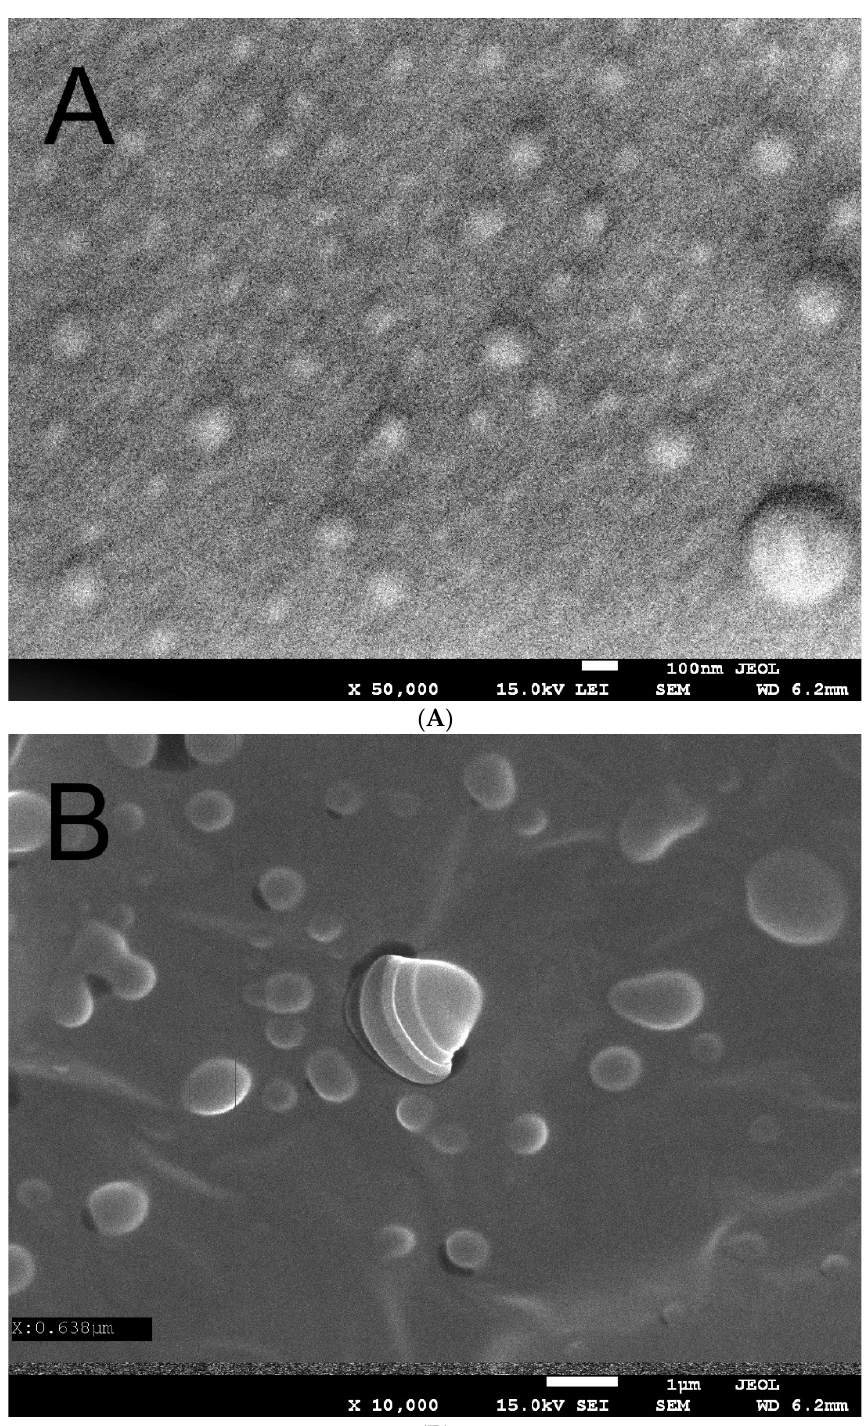
Figure 1. Scanning electron microscope image of the Hyal/O 3 at ×50,000 ( A ) and ×10,000 ( B ) magnification. The UV-Vis spectra in the spectral range of 200–800 nm for the Hyal and Hyal/O 3 films are presented on Figure 2.